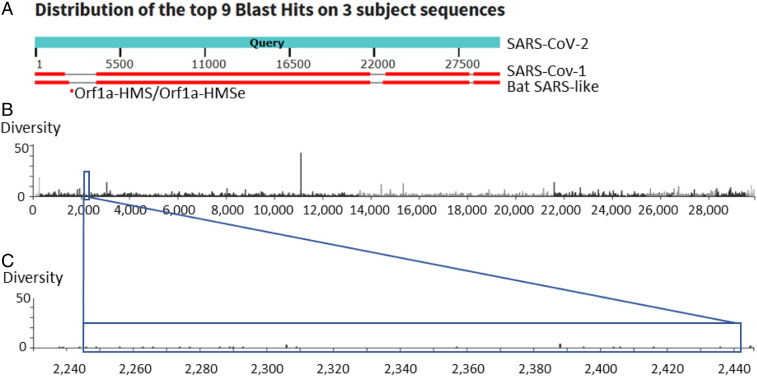
Sequence conservation of Orf1a-HMS target region between related coronaviruses and within SARS-CoV-2 isolates. (A) An alignment (blastn, megablast) of SARS, Bat SARS-like coronavirus isolate Rs4084, and the sequence detected by Orf1a-HMS/Orf1a-HMSe. (B and C) Measure of sequenced nucleotide mutations in a subset of global data provided by Nextstrain (nucleotide entropy), adapted from Nextstrain visual interface. Orf1a-HMS/Orf1a-HMSe target region (2245 to 2441) indicated. (B) Whole genome view. (C) Close-up of the target region.